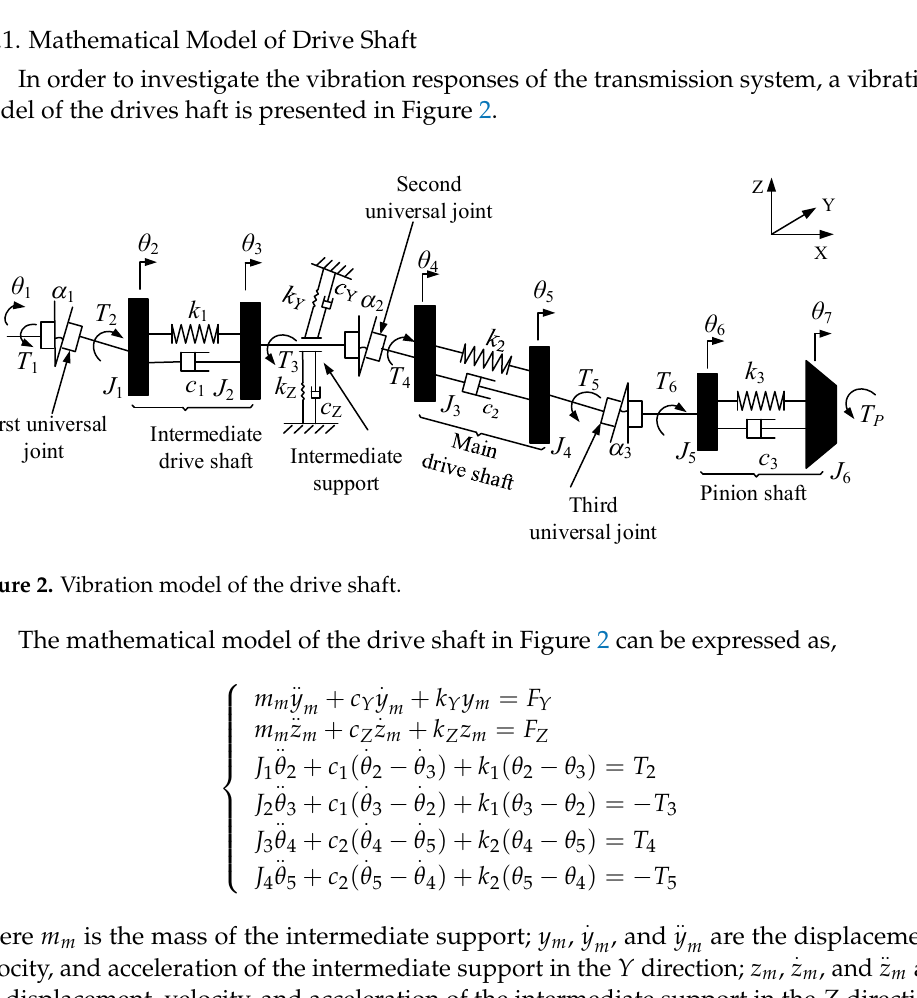
Figure 1. Structural model of the transmission system.